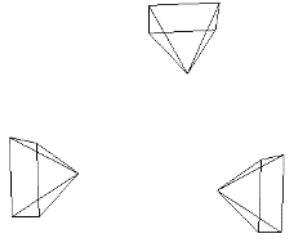
Figure 4. Relative positions of the three Kinects.